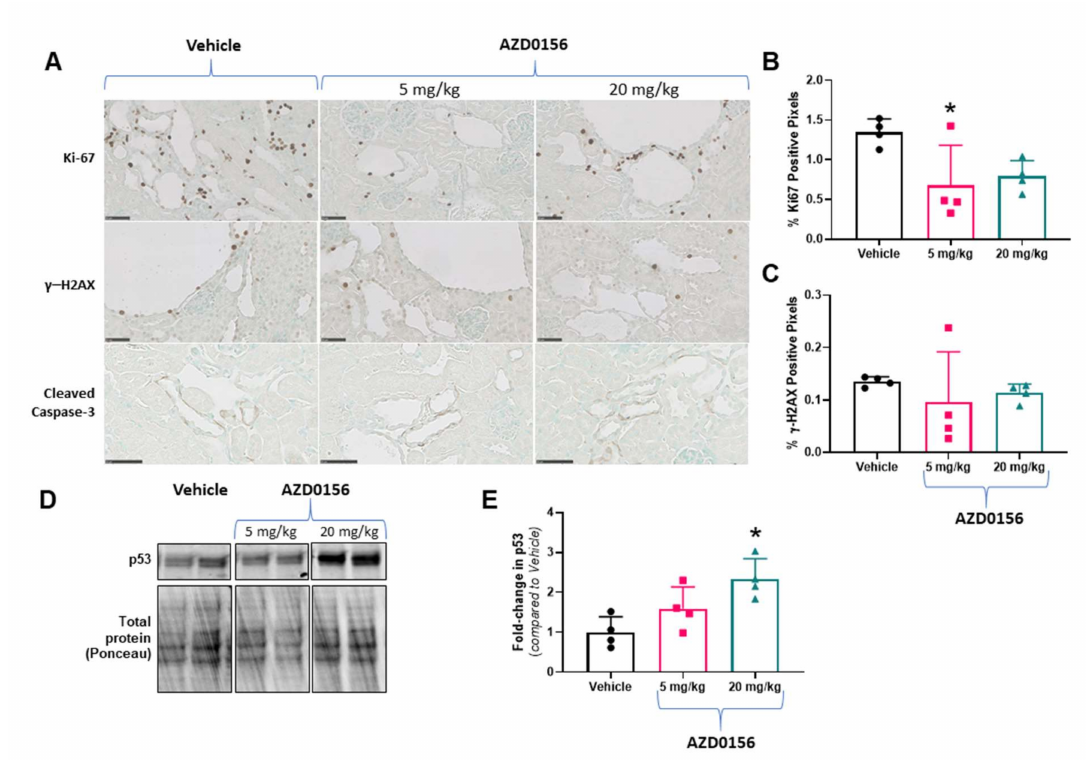
Figure 4. Effect of AZD0156 on renal cell proliferation, DNA damage and p53 in Pkd1 RC/RC mice. ( A ) Representative histological images of renal cortex showing Ki-67+ cells (DAB-positive cells) (upper panel), gH2AX (middle panel), and cleaved caspase-3 (lower panel) in the experimental groups. Scale bars, 50 µ M. ( B ) Mean Ki-67-positive pixel quantification in the experimental groups. ( C ) Mean γ -H2AX-positive pixel quantification in the experimental groups. ( D , E ) Representative western blots and quantitative analysis for renal p53 expression; * p < 0.05 compared to vehicle; Data presented as means ± SD ( n = 4 per